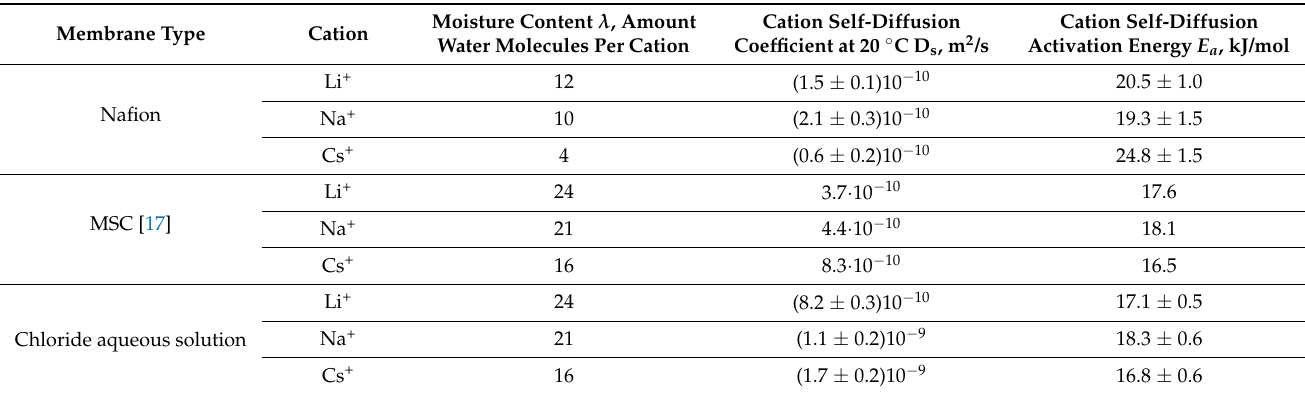
Figure 41. Temperature dependences of Cs + , Na + , Li + diffusion coefficients in appropriate ionic form of MSC membrane at RH = 95%: (1) Cs + ionic form, E a = 18.1 kJ/mol; (2) Na + ionic form, E a = 16.5 kJ/mol; (3) Li + ionic form, E a = 17.6 kJ/mol [17]. Self-diffusion coefficients at 20 ◦ C, self-diffusion activation energies of Li + , Na + , and Cs + cations in Nafion membrane are indicated in Table 8. The values of Li + , Na + , Cs + self- diffusion coefficients and activation energies in MSC sulfonic cation-exchange membrane and dilute chloride aqueous solution are also given for comparison [17]. Table 8. Moisture content λ , amount water molecules per cation, self-diffusion coefficients D s , at 20 ◦ C, self-diffusion activation energies E a of Li + , Na + , and Cs + cations in Nafion membrane, MSC membrane at RH = 95% and chloride aqueous solutions